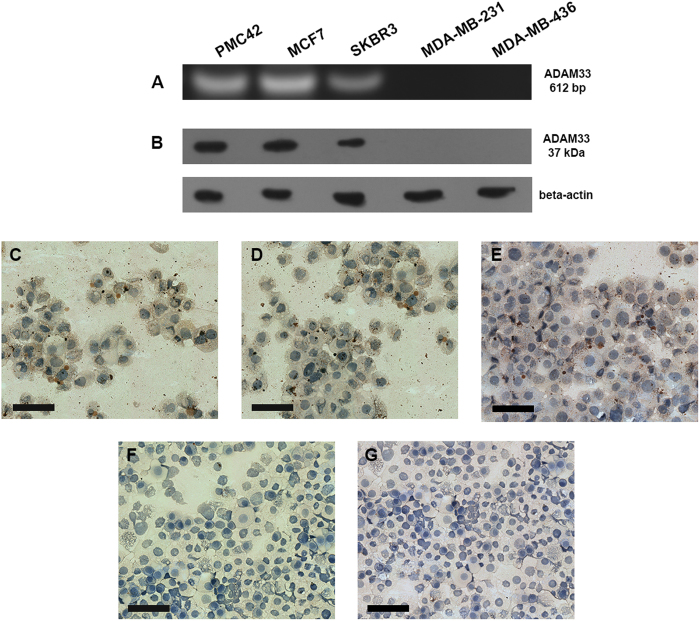
ADAM33 expression in breast cancer cell lines.(A) RT-PCR of breast cancer cell lines: PMC42, MCF7 and SKBR3 cells show the amplification of a 612-bp fragment while no amplification is observed in MDA-MB-231 and MDA-MB-436 cells. (B) Western blotting of breast cancer cell lines using an anti-ADAM33 antibody, which shows a positive signal in PMC42 (line 1), MCF7 (line 2), SKBR3 (line 3) and no signal in MDA-MB-231 (line 4) and MDA-MB-436 (line 5). Beta-actin was used as the Western blotting control. Immunocytochemistry of breast cancer cell lines using an anti-ADAM33 antibody shows positive staining in PMC42 (C), MCF7 (D), SKBR3 (E) and negative staining in MDA-MB-231 (F) and MDA-MB-436 (G) cells. The IHC results are shown at X100 magnification.